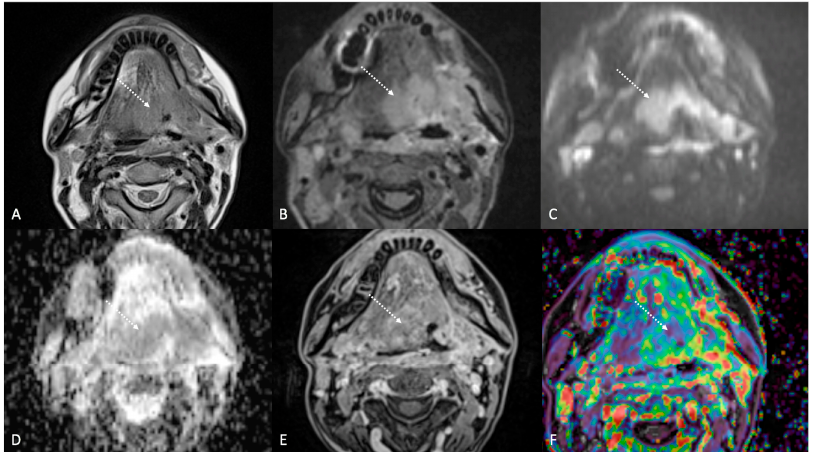
Figure 5. Post-treatment magnetic resonance imaging (MRI) of a 47-year-old female patient with human-papillomavirus-negative carcinoma of the left palatine tonsil with ipsilateral lymph node metastasis (T4aN1) and buccal space and mandibular invasion, recently treated (4 months before) with chemoradiotherapy (CRT). Early post-treatment MRI showed tumor progression with wide extension to the extrinsic muscles of the contralateral tongue (maximum tumor thickness 45 mm). Post-CRT tumor residual/relapse disease (white striped arrows) showed moderately high (intermediate) T2-weighted signal intensity ( A , B ), high signal on diffusion-weighted b800 imaging ( C ), low apparent diffusion coefficient value (0.79 × 10 − 3 mm 2 /s, ( D ), and moderate enhancement after gadolinium contrast injection ( E ). K(trans) value of the tumor (56.24 × 10 − 3 min) decreased on dynamic contrast enhancement-perfusion weighted imaging ( F ), compared to pre-treatment MRI (117.63 × 10 − 3 min). However, the ratio between K(trans) values of the primitive tumor and residual tissue after CRT, standardized with respect to K(trans) value of the ipsilateral trapezius (K(trans) post/pre/muscle ), was 1.14. These findings suggested little or no reduction in tumor neoangiogenesis after CRT.